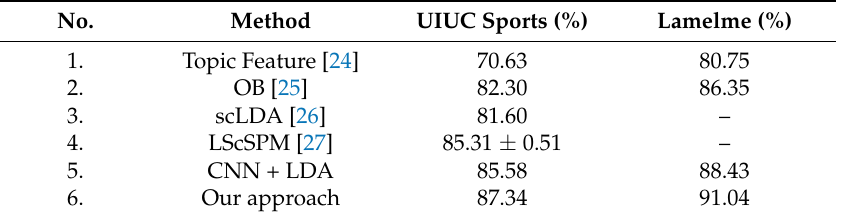
Table 2. The classification accuracy of different methods on different datasets.